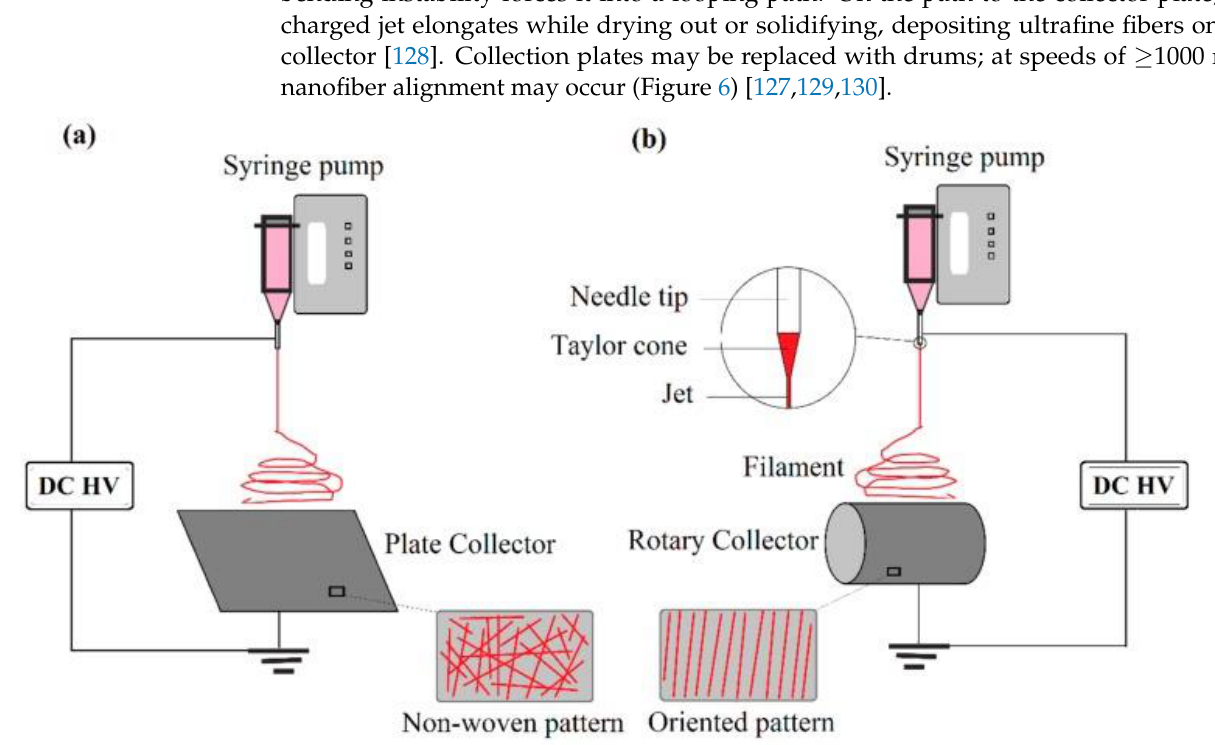
Figure 6. A typical electrospinning set up [130] using ( a ) a static grounded collector plate and ( b ) a grounded rotating drum collector. Reprinted from Ref. [130], available at https://doi.org/10.3390/ma10111238; accessed on 1 December 2022.